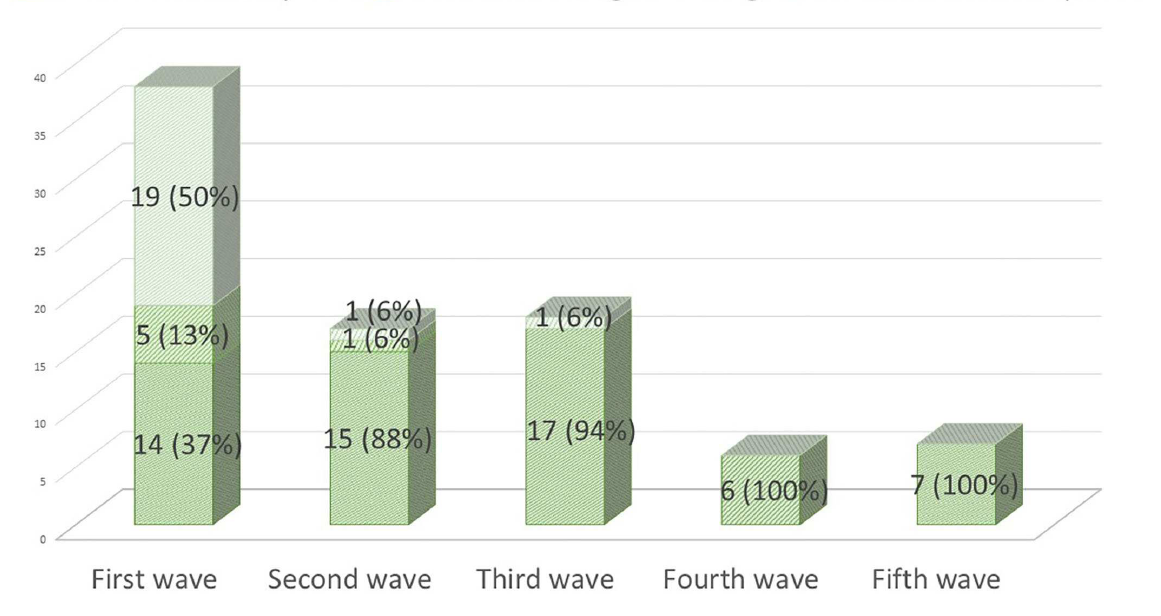
FIGURE2 COVID-19 cases during the first five waves (1 March 2020 to 28 September 2021) and diagnostic criteria